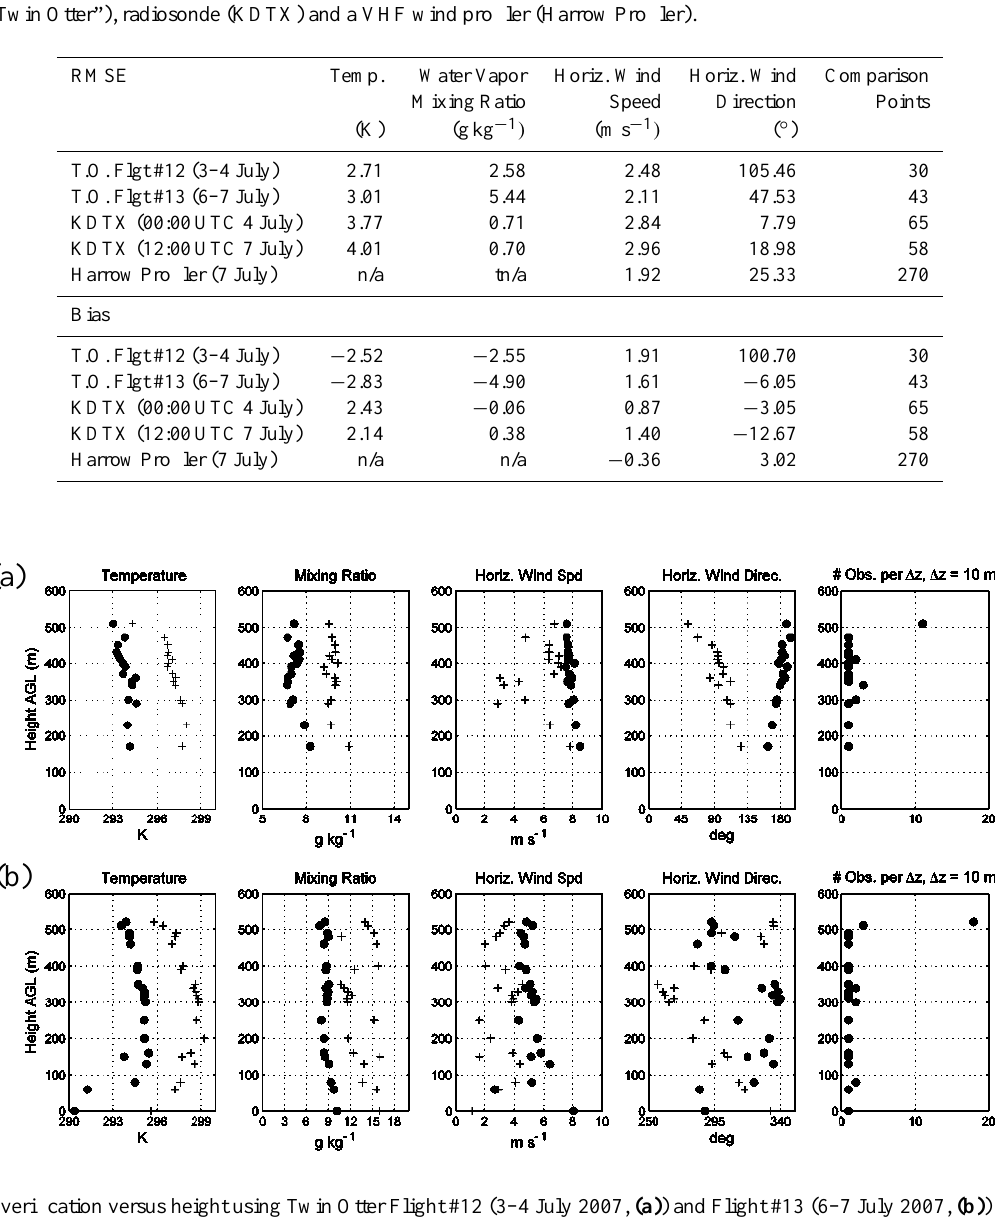
Fig. 3. Model verification versus height using Twin Otter Flight #12 (3–4 July 2007, (a) ) and Flight #13 (6–7 July 2007, (b) ) measurements intercepting the third model grid. Variables depicted include: temperature, water vapor mixing ratio, scalar-average horizontal wind speed and horizontal wind direction. Model estimates are interpolated to observations and both are organized into 10m bins. Each column shows the (bin-averaged) observed values (+) and model estimates (circles). The number of comparison points contributing to each bin is shown at the far